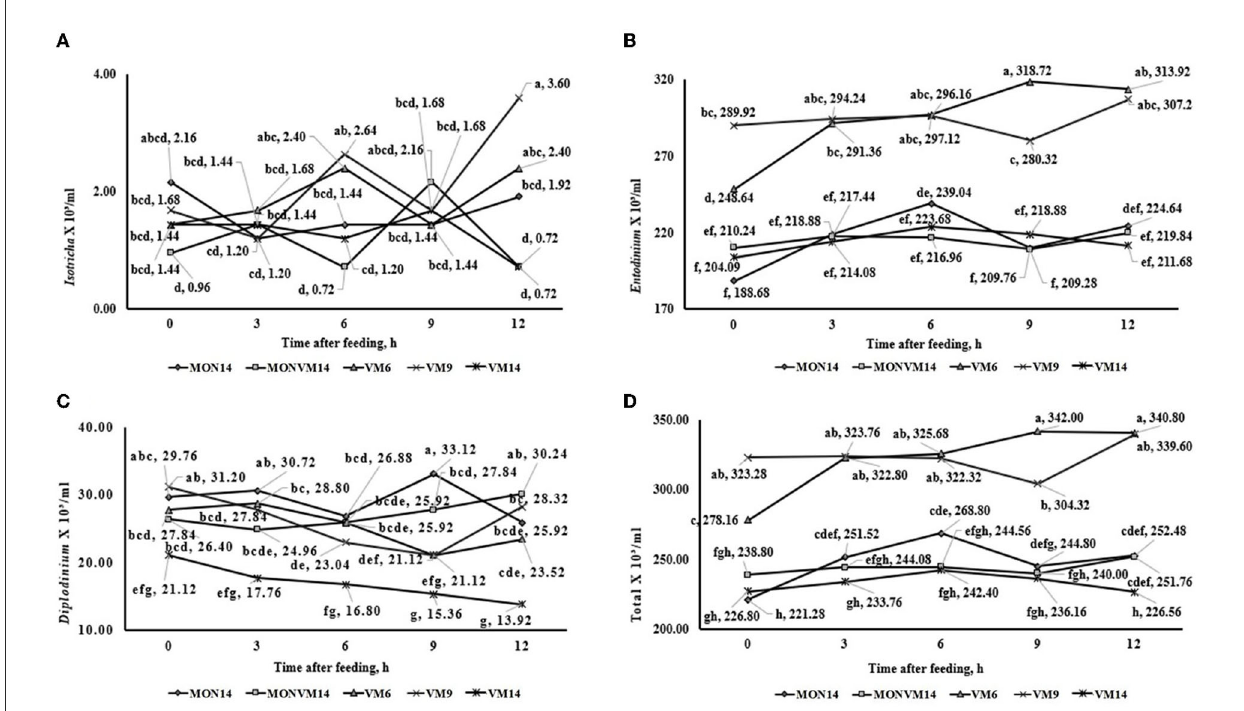
FIGURE3 This is a figure with sub figures. (A) Interaction between treatments 2 and hours after treatment on total ruminal Isotricha count (ml3/ml) of rumen-cannulated Nellore cattle fed high-concentrate diets containing sodium monensin (MON), virginiamycin (VM) or both on the 2th day after adaptation period. (B) Interaction between treatments and hours after treatment on total ruminal Entodinium count (ml3/ml) of rumen-cannulated Nellore cattle fed high-concentrate diets containing sodium monensin (MON), virginiamycin (VM) or both on the 2th day after adaptation period. (C) Interaction between treatments and hours after treatment on total ruminal Diplodinium count (ml3/ml) of rumen-cannulated Nellore cattle fed high-concentrate diets containing sodium monensin (MON), virginiamycin (VM) or both on the 2th day after adaptation period. (D) Interaction between treatments and hours after treatment on total ruminal protozoan count (ml3/ml) of rumen-cannulated Nellore cattle fed high-concentrate diets containing sodium monensin (MON), virginiamycin (VM) or both on the 2th day after adaptation period.